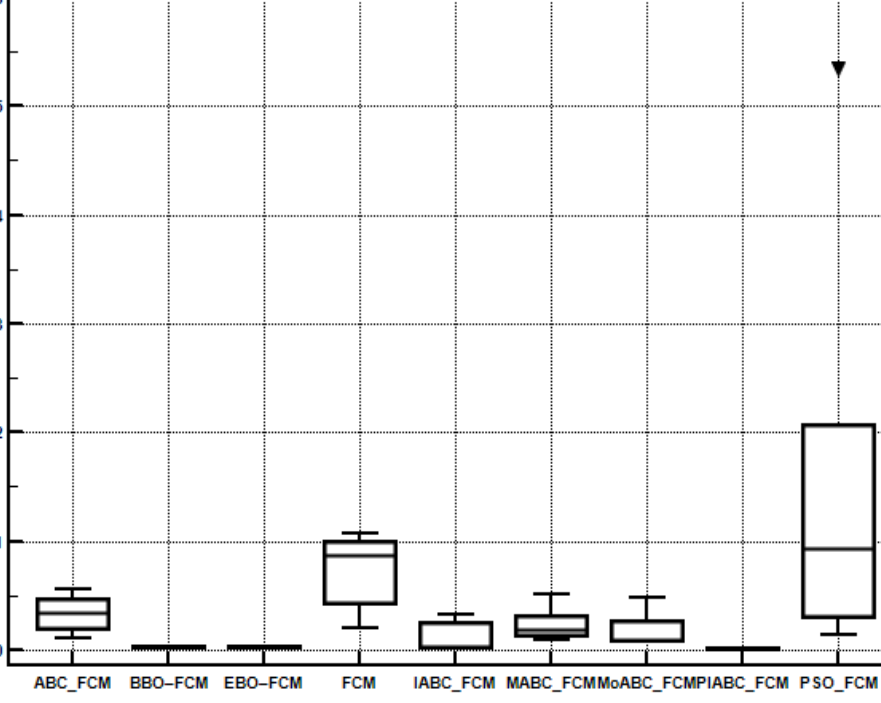
Figure 7. Box-whisker graph to present the outcomes of the SC index.